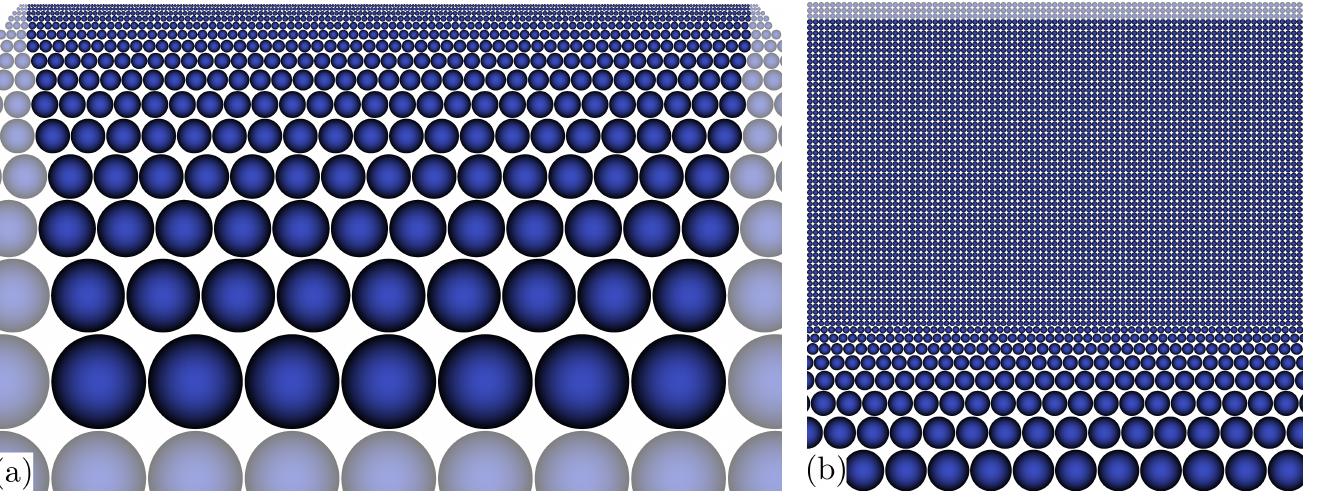
Figure 4. Particle discretisation of computational domain, dummy particles less opaque, details: ( a ) 7.5 µm × 4.4 µm, coarse particles start at the bottom, ( b ) 440 nm × 440 nm, near-surface equidistant initial array and coarsening.